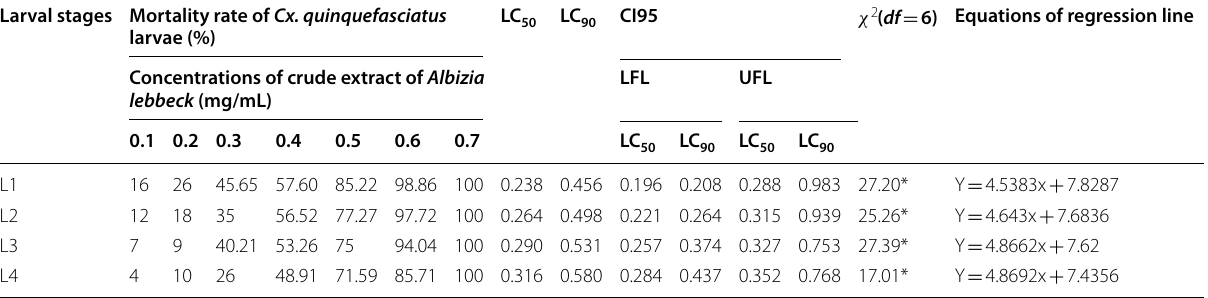
LFL, lower fiducidal limit; UFL, upper fiducidal limit; χ 2 , Chi- square value; df , degrees of freedom; CI, confidence interval *Significant at P < 0.05 level